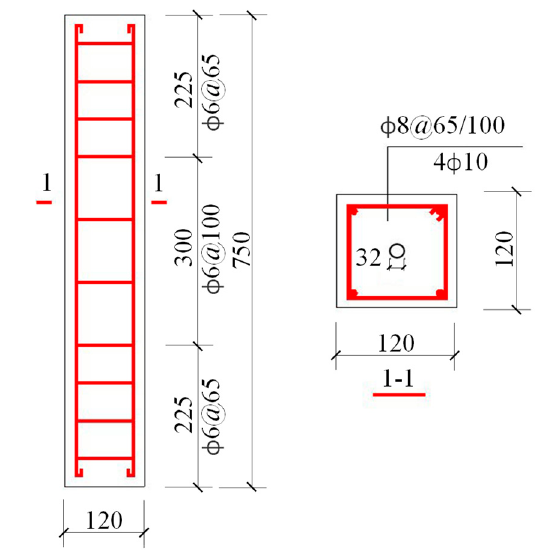
Figure 1. Details of RC column specimens (unit: mm).